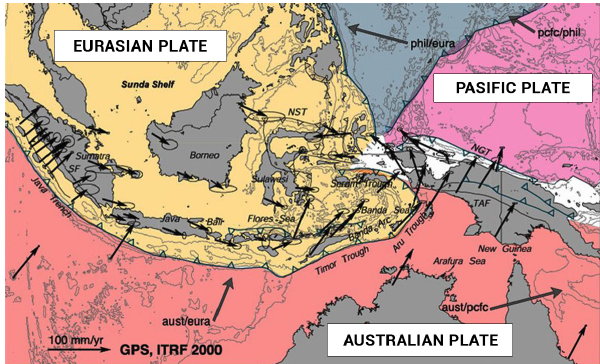
Fig. 2. Tectonic Map of Indonesia Source: Meteorology